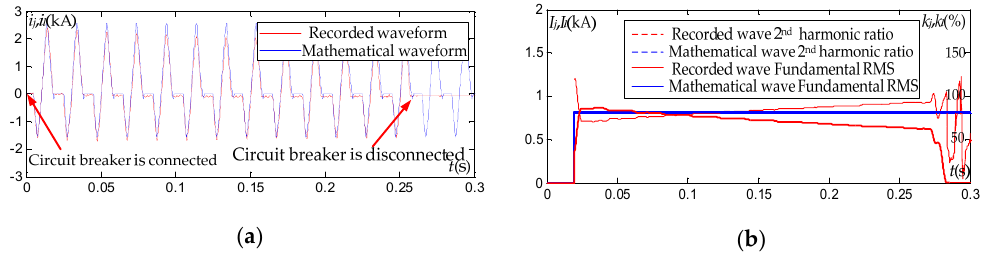
Figure 5. Graphical representation for waveform Number Two: ( a ) original waveform; ( b ) fundamental RMS and second harmonic ratio.